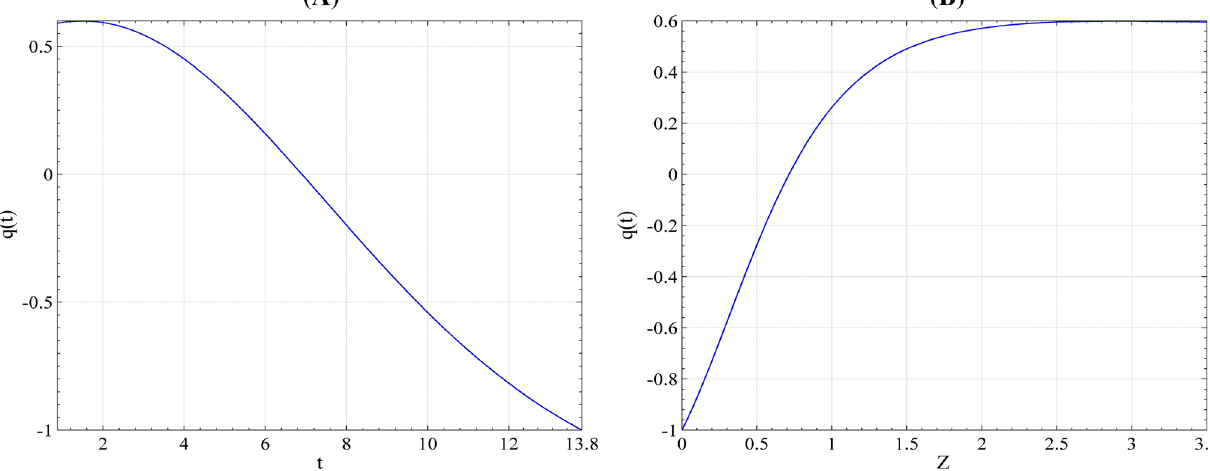
Fig. 3 Plot a indicates the deceleration parameter q ( t ) versus time t at the time range [ 1 , 13 . 816 ] , while plot b shows the deceleration parameter q ( t ) versus redshift z at the redshift range [ 0 , 3 . 5